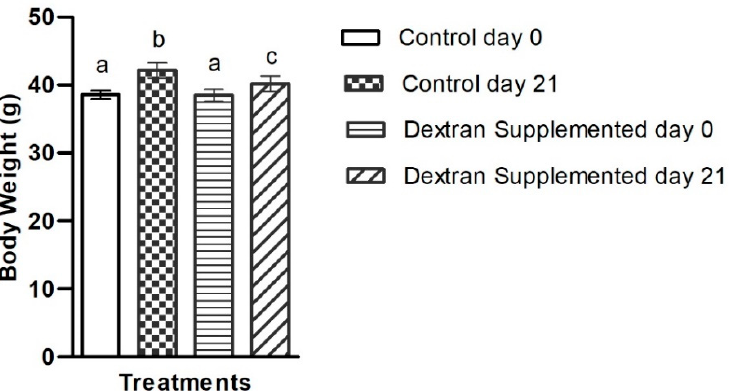
Figure 7. Average body weight gain in control and Apilactobacillus waqarii EPS supplemented group in comparison of day 0 and 21. The values of data sets ( n = 6) denoted by different alphabet are significantly different ( p < significantly different ( p < 0.05).